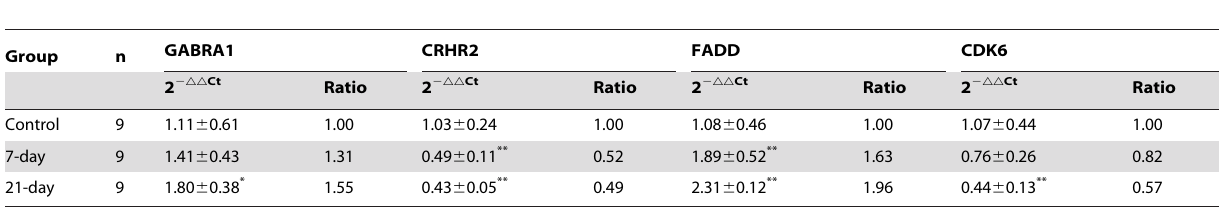
Table 4. Relative quantitative analyses of the Gabra1 , Crhr2 , Fadd , and Cdk6 genes expression in the rat hippocampal tissues of three